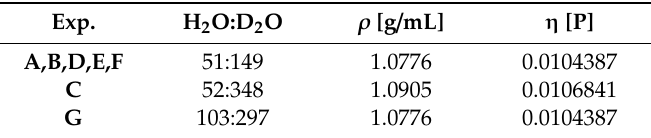
Table 2. Density and viscosity of the solvent used for the analysis of the gold clusters dependent on the